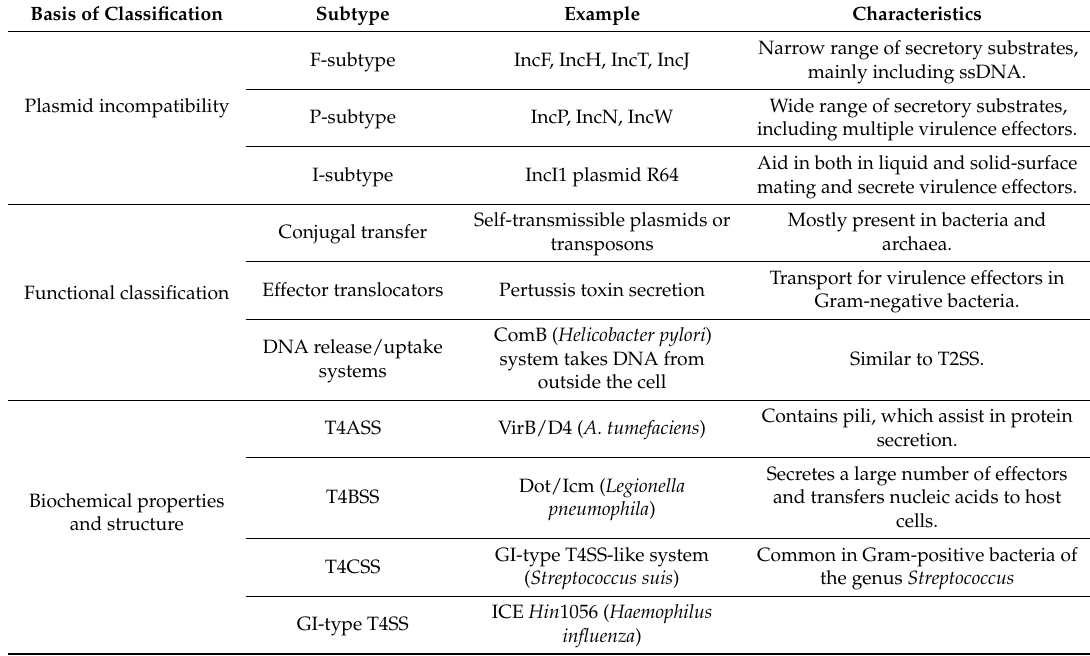
Table 1. Classification of T4SS.